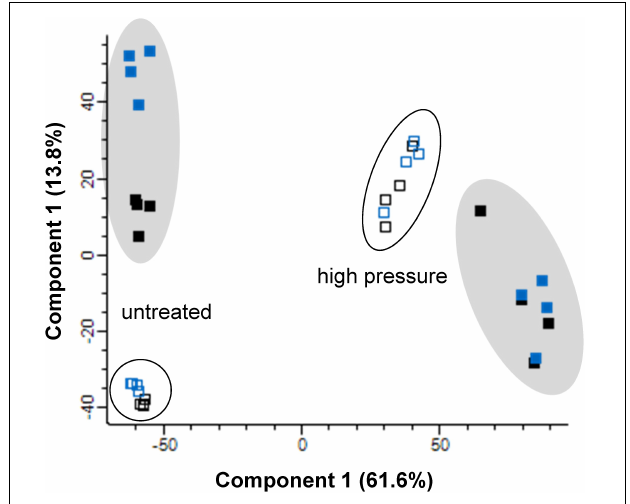
FIGURE 1 | Principle component analysis of proteomic data for inclusion bodies (filled) and whole cell extracts (open) in E. coli MG1655 ibpA-yfp carrying pLHR (blue) or pRK767 (black). Cells were analyzed without treatment, or after treatment at 400 MPa for 3 min. Proteome analyses were performed in quadruplicate independent experiments with technical repeats for each sample.